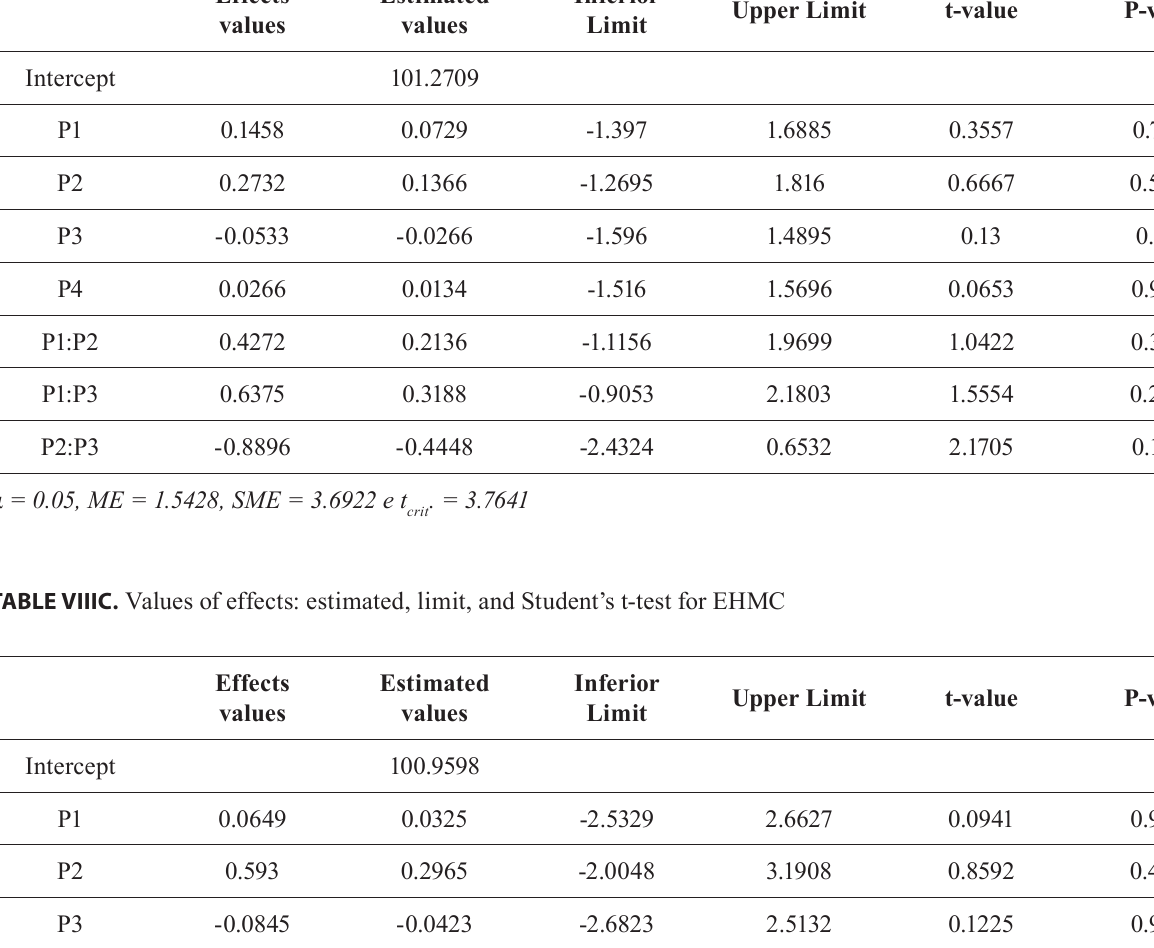
TABLE VIIIB – Values of effects: estimated, limit, and Student’s t-test for BMDBM Effects